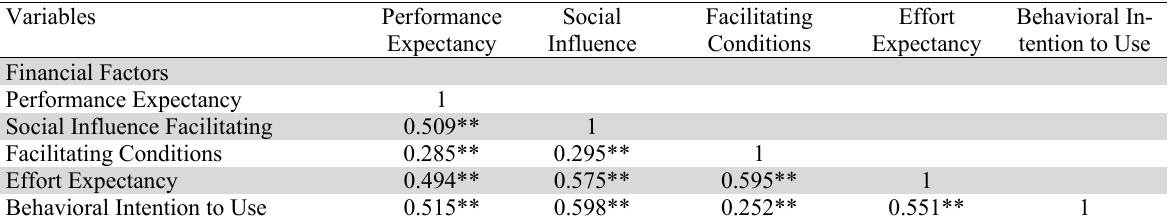
Correlation between constructs UTAUT and behavioral intention